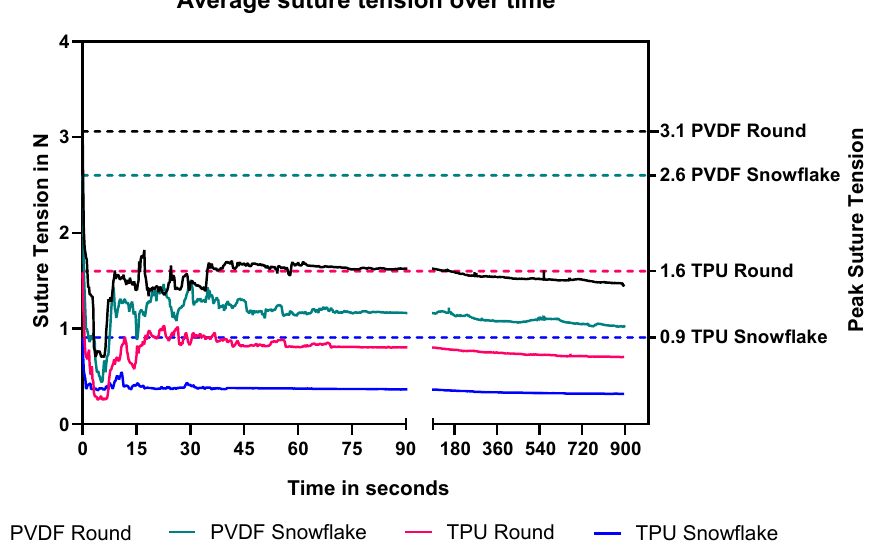
Figure 5. Average suture tension over time. Note the varying scale of the x -axis to better illuminate the short-term and long-term tension behaviour of the sutures. Second y -axis highlights peak suture tensions of each suture.